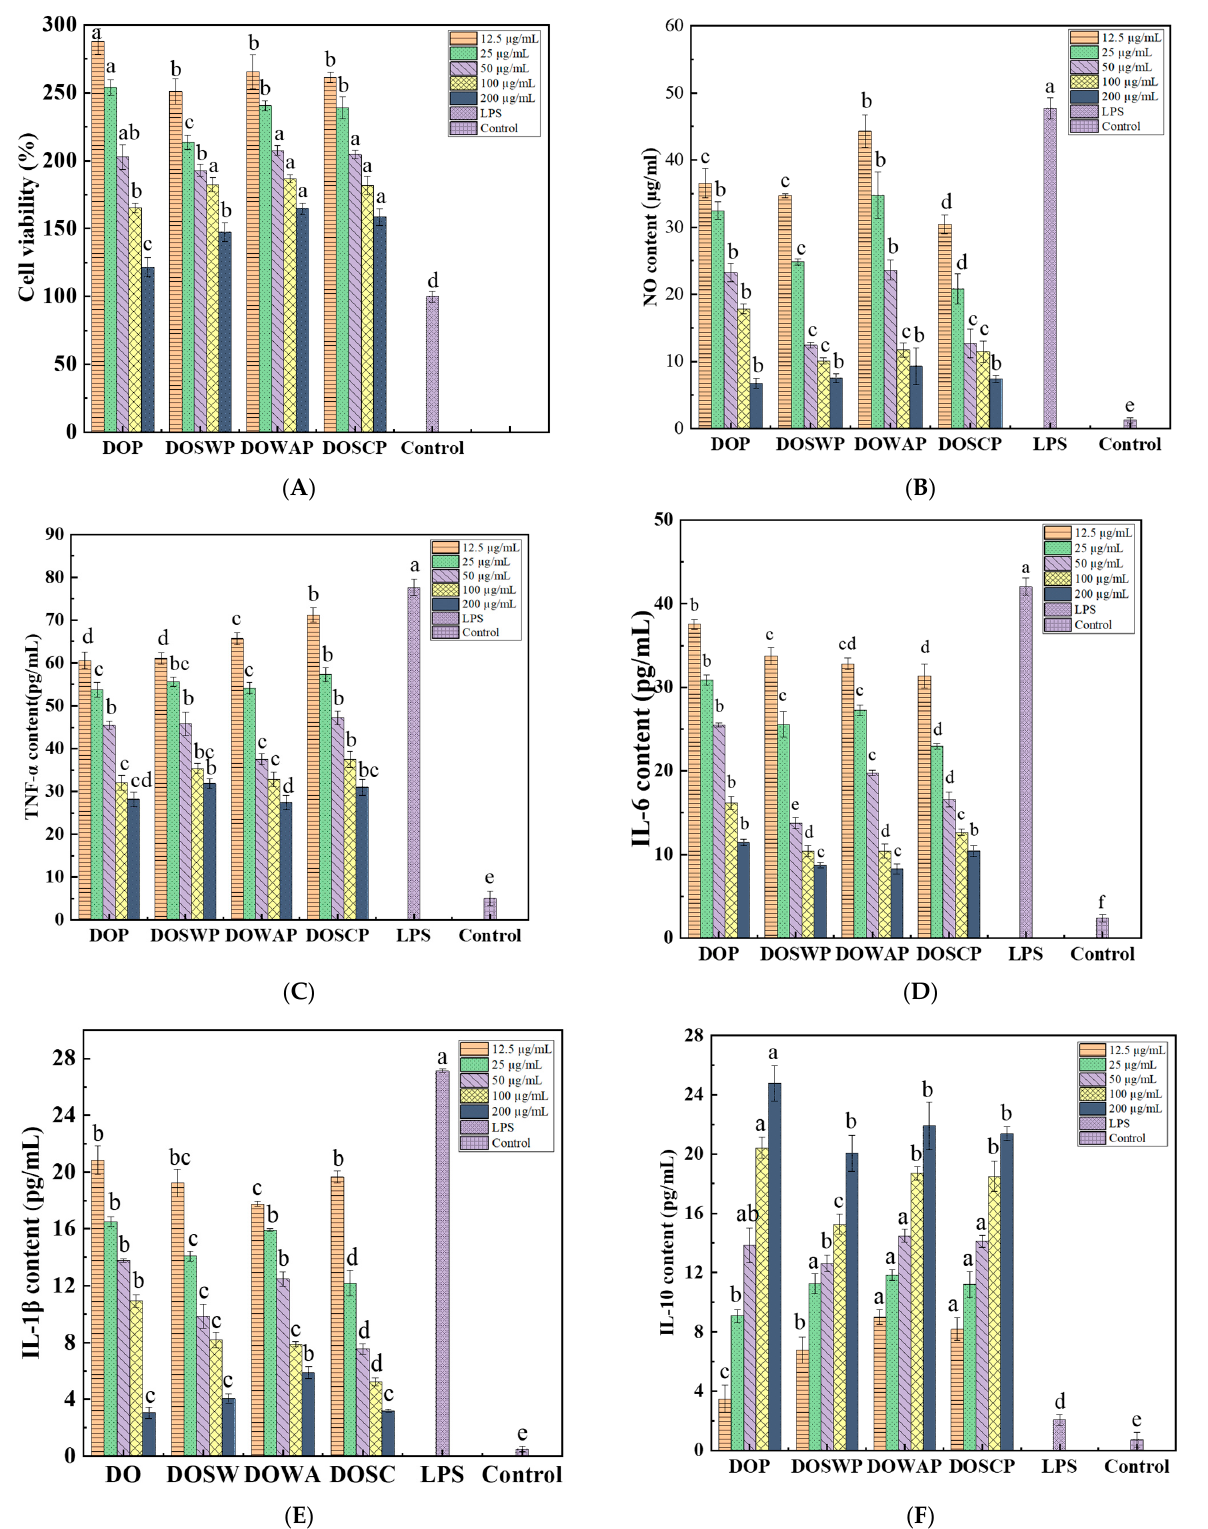
Figure 3. Effect of polysaccharides on the proliferation of murine macrophage RAW 264.7 cells ( A ); Effect of polysaccharides on the content of NO ( B ), TNF- α ( C ), IL-6 ( D ), IL-1 β ( E ), IL-10 ( F ) in murine macrophage RAW 264.7 cells. Different lowercase letters above the columns indicate significant differences among groups ( p < 0.05).